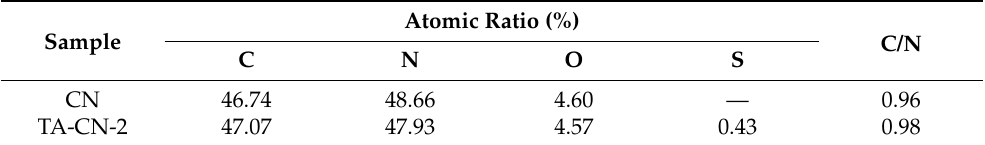
Figure 4. High-resolution XPS spectra of ( a ) C 1s, ( b ) N 1s, ( c ) O 1s of CN and TA-CN-2. ( d ) High-resolution XPS spectrum of S 2p of TA-CN-2. Table 1. The C, N, O, S elemental compositions and C/N molar ratios of the samples according to